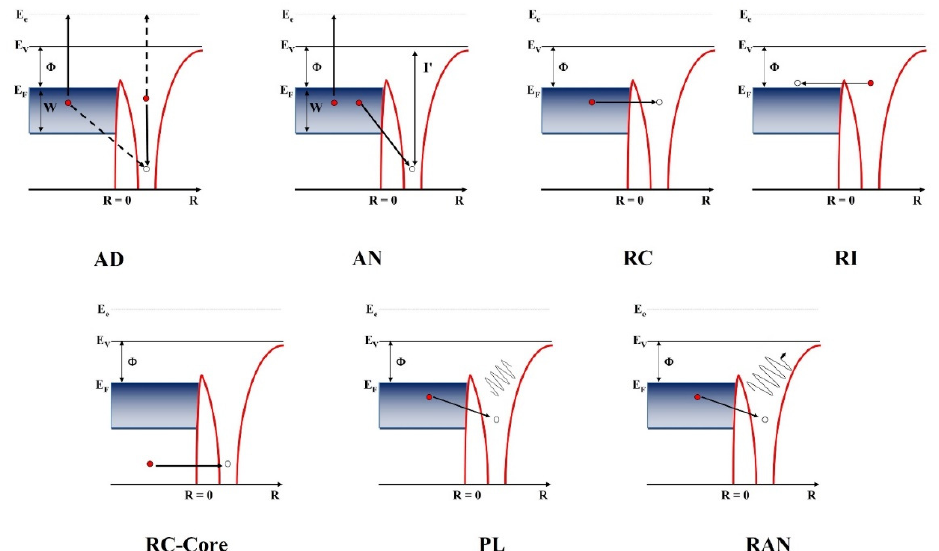
Figure 1. One-electron and two-electron transition that occurs for ions and excited atoms close to a solid surface. AD, Auger Deexcitation; AN, Auger Neutralization; RC, Resonant Capture; RI, Reso- nant Ionization; RC-Core, Resonant Capture from core level; PL, Plasmon Assisted Neutralization; RAN, Radiative Neutralization. In the figures, R is the distance from the surface, W is the width of the band, E v and E F are the vacuum and Fermi level, respectively, Φ is the metal work function, and E e is the energy of the electron emitted in vacuum.